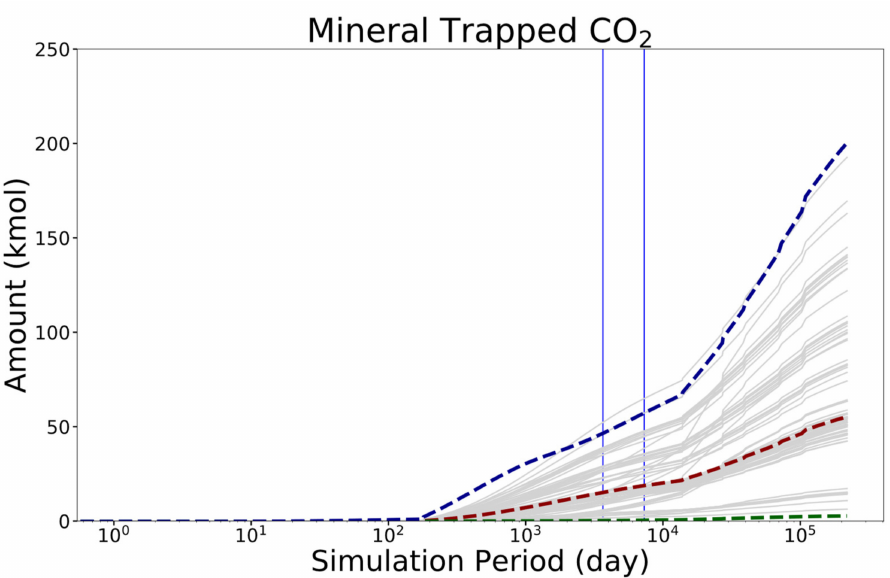
Figure 5. The predicted amount of mineral trapped CO 2 in the simplified 3D model. Dashed lines in dark green, dark red, and dark blue indicate Case#86, Case #85, and Case #87, respectively; gray lines denote all other cases, and two vertical lines denote the end of 10 years and the end of 20